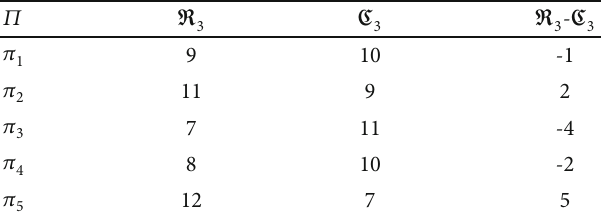
Table 9: The third positive pole score table.